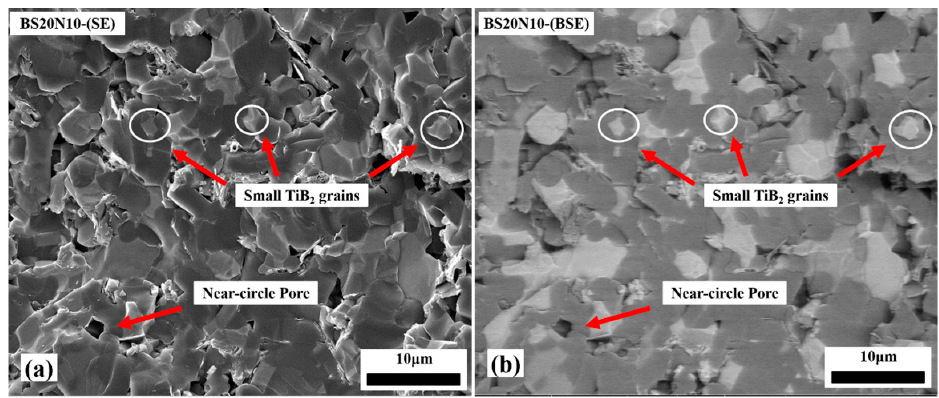
Figure 4. Small TiB 2 grains in the B 4 C/TiB 2 ceramic composite processed with a mixture of sub-micron and nano-sized TiB 2 particles. ( a ) SEM image and ( b ) corresponding BSE image.